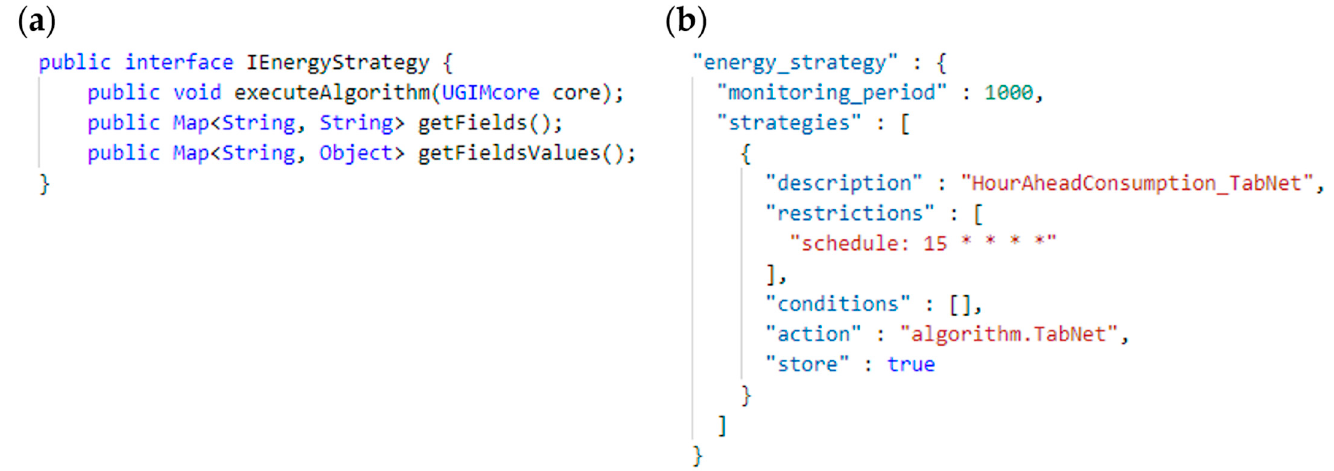
Figure 2. Energy strategies: ( a ) IEnergyStrategy class; ( b ) configuration of an energy strategy in the configuration file.